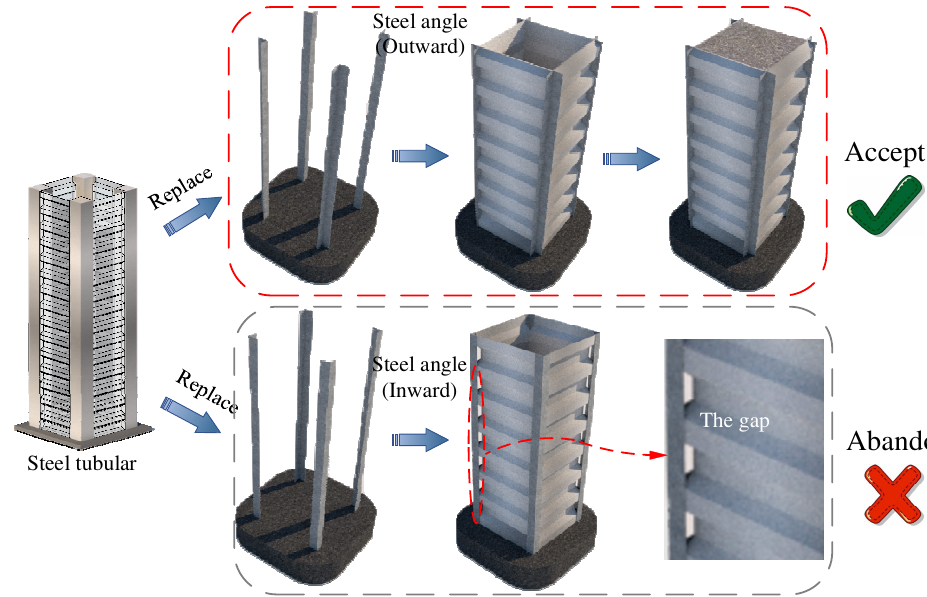
Figure 2. Form of SA-CS column.